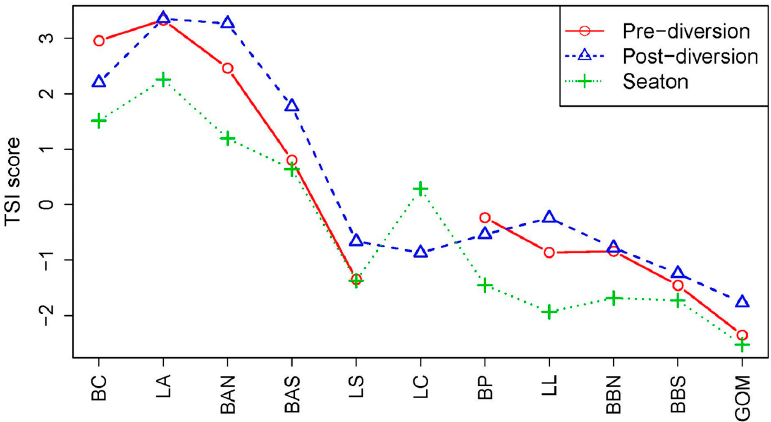
Figure 4. Trophic State Index scores for station groupings for the Seaton, Pre-diversion and Post-diversion transects for 4-variable analysis. Table 3. Trophic State Index (TSI) scores for 4-variables and 5-variables